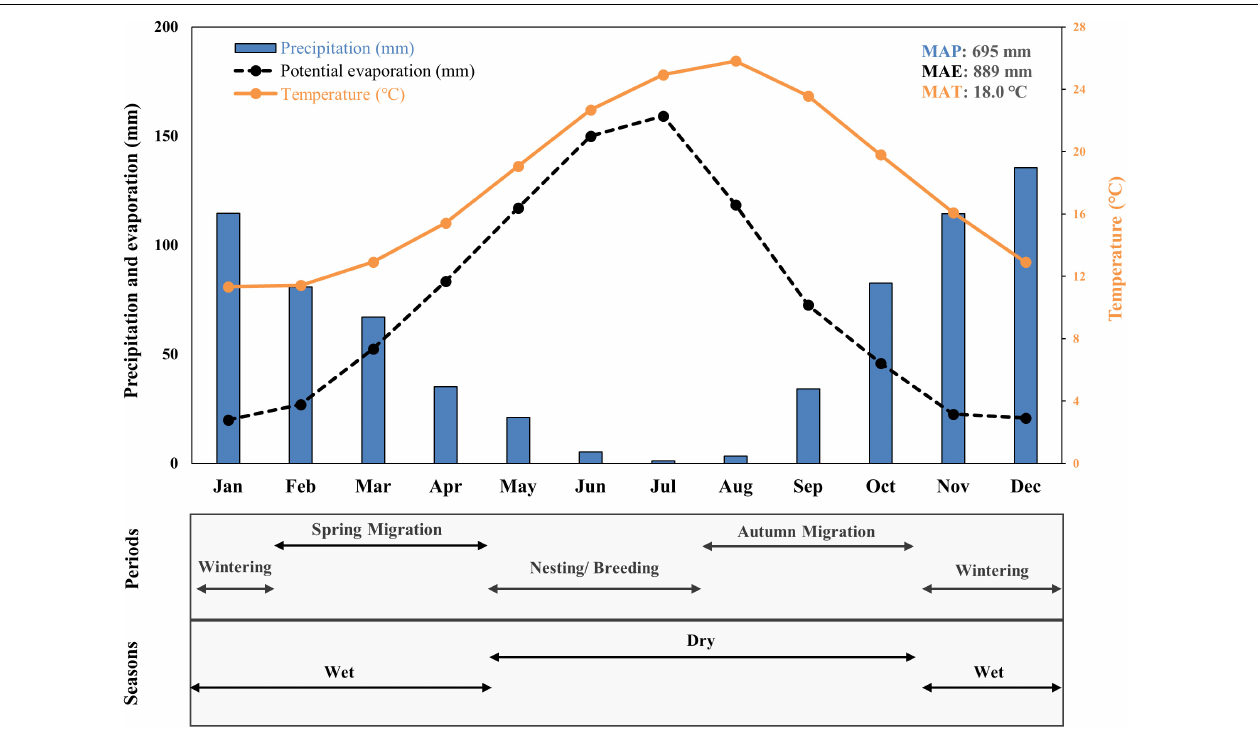
FIGURE 2 | Graph by Maneas et al. (2019), showing monthly mean precipitation (MAP), evaporation rate (MAE) and temperature (MAT) at the study area for the period 1956–2011. At the bottom, a graph showing the birds’ periods and seasons used for the analyses.